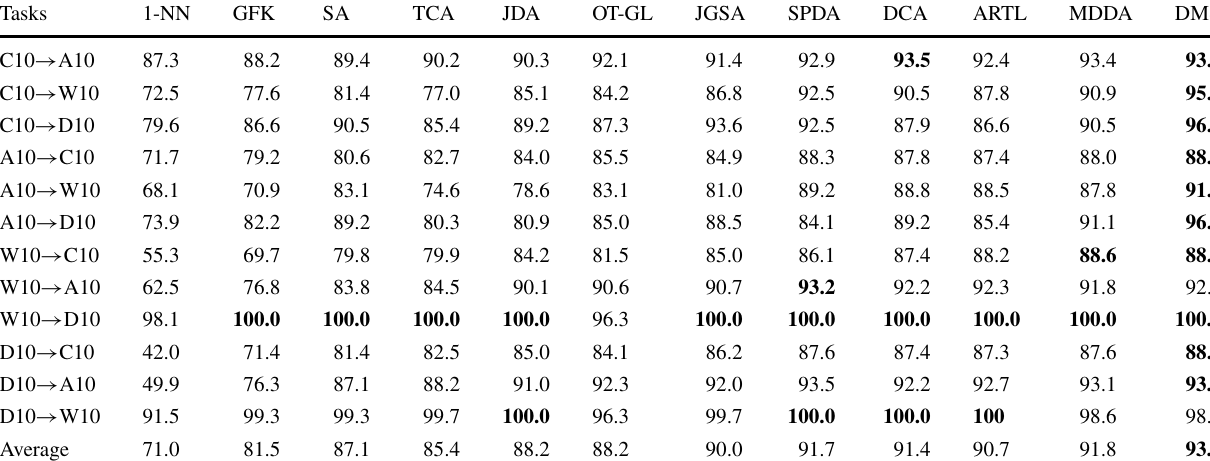
The best results are marked in bold Table 3 Accuracy (%) on Office + Caltech (Decaf6)